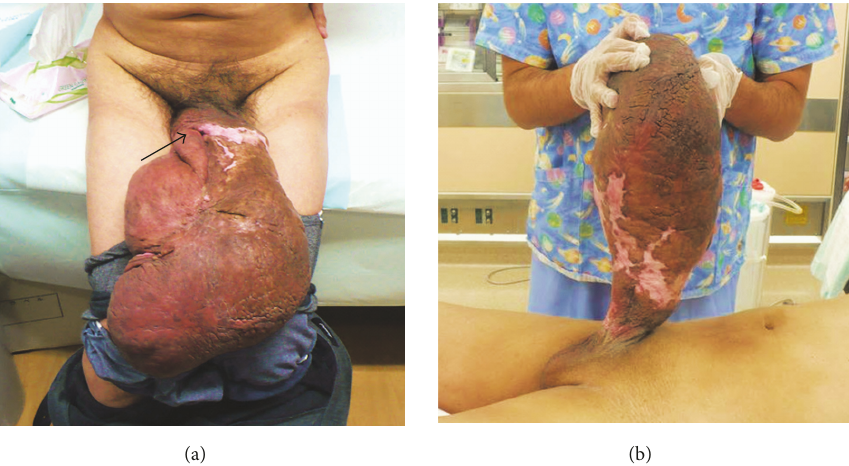
Figure 1: (a) Giant hypertrophic skin completely covering the penis. Black arrow indicates penile orifice. (b) Preoperative view of patient with giant penile lymphedema and normal scrotum.